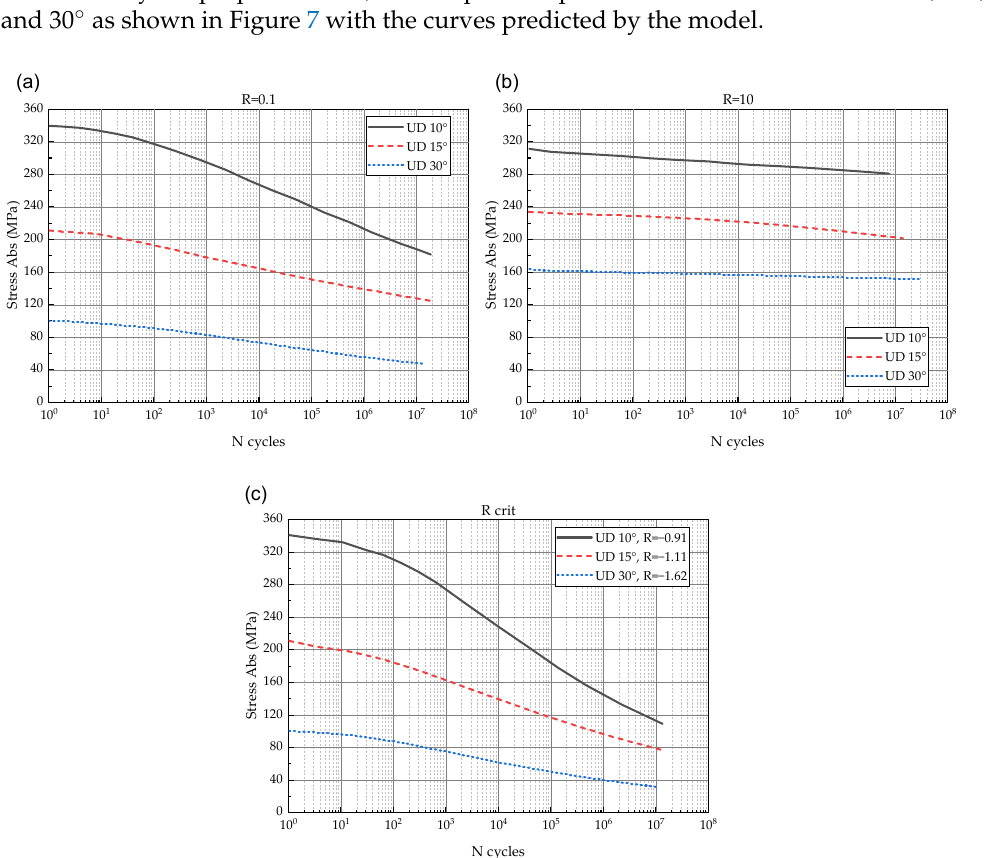
Figure 7. S-N curves used for verification of the FDM [29]: ( a ) UD 10 ◦ , ( b ) UD 15 ◦ , ( c ) UD 30 ◦ . The simple ABAQUS FE model was built to estimate the fatigue life of FRP samples with various fiber orientations (see Figure 8). X-axis is a reference axis for composite fiber orientation. Dimensions of the FE model were the same as the dimensions of UD samples shown in Table 1. The C3D8 linear brick elements with a characteristic size of 1 mm were used.